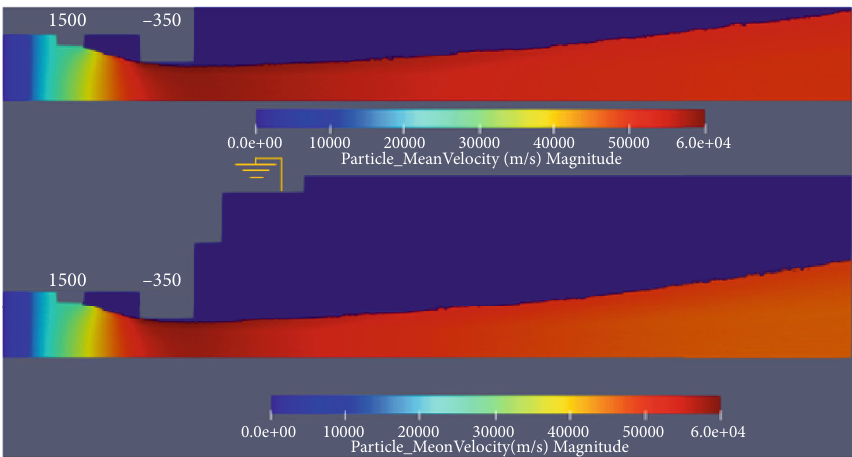
Figure 3: Velocity distribution of Xe + with (lower) and without (upper) the engine cover.